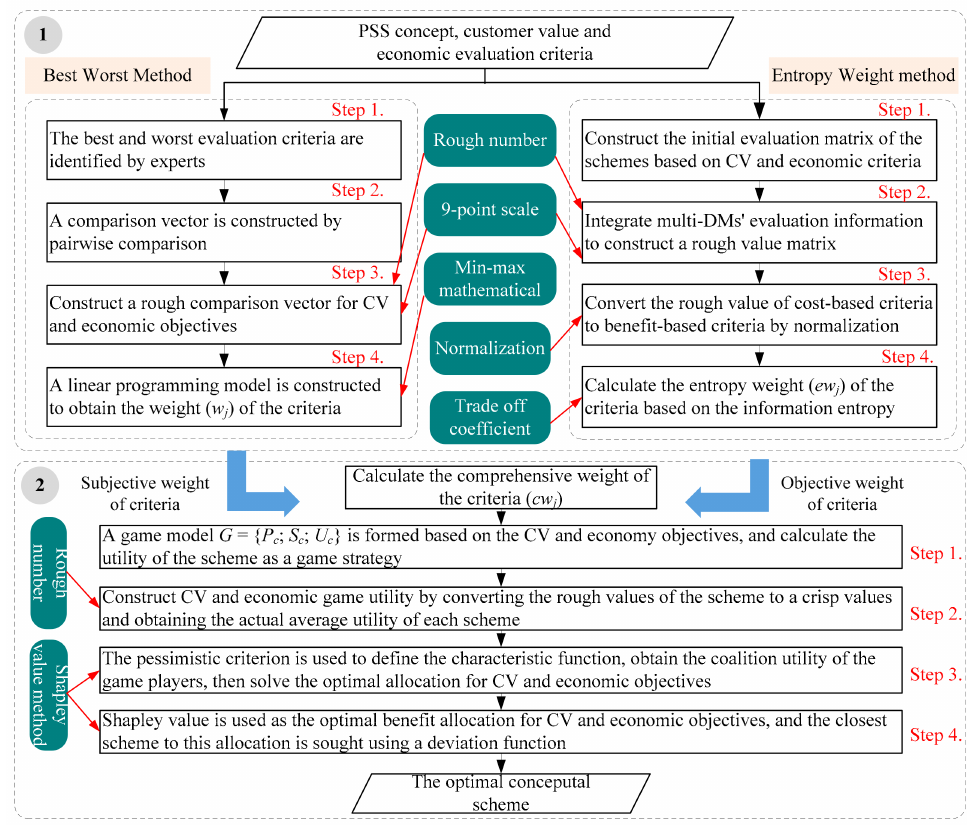
Figure 1. Framework of the proposed decision model. Table 2. Morphology matrix of